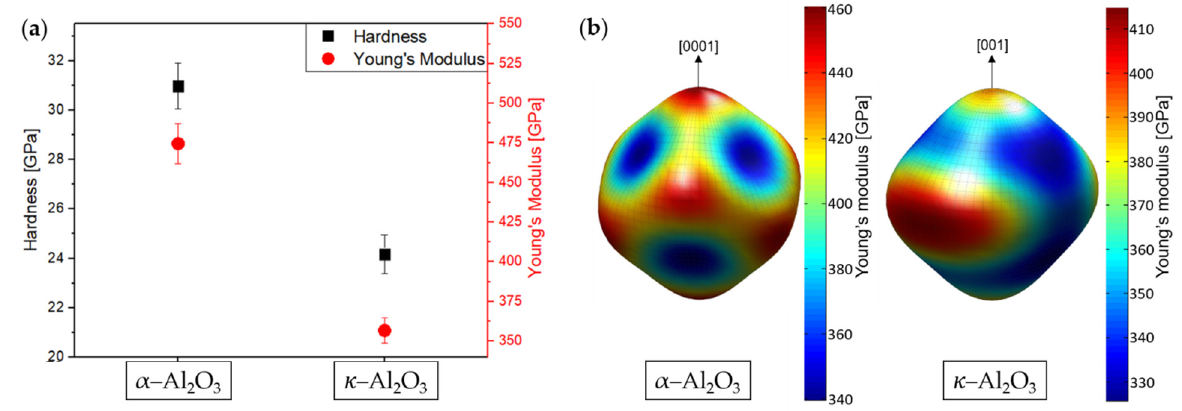
Figure 3. ( a ) Hardness and Young’s modulus of the α – and κ –Al 2 O 3 coating evaluated by nanoindentation and ( b ) direction dependent Young’s modulus of α – and κ –Al 2 O 3 calculated from single crystal constants. Please note the different scale bars for α – and κ –Al 2 O 3 .